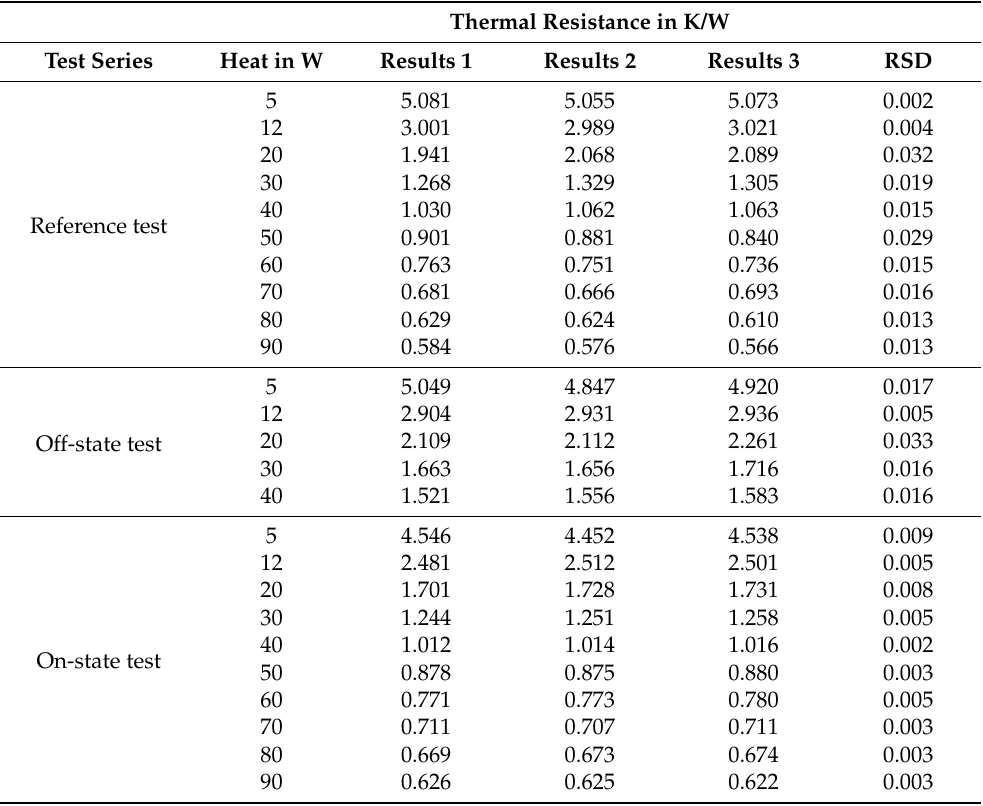
Table 2. Thermal resistance of the tested thermosiphons for different heating levels.